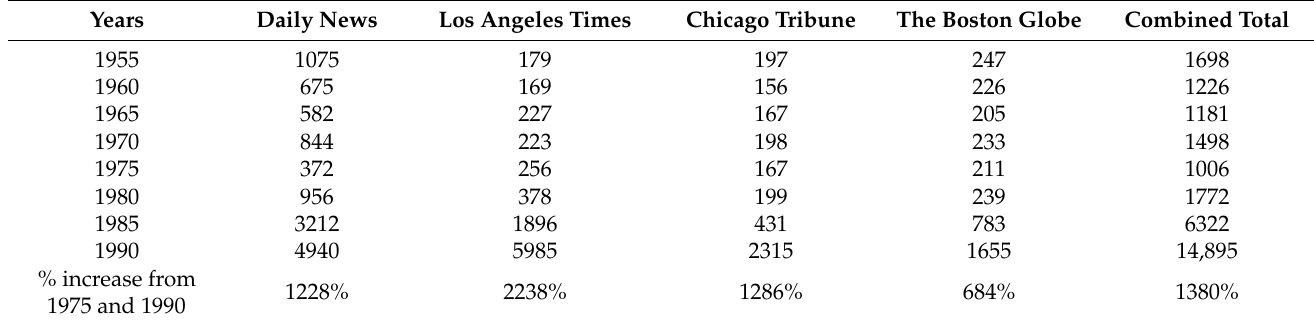
Table 1. The frequency of the word “homeless” in major newspapers between 1955–1995. Data were collected from an online digital archive of newspapers, Newspaper.com on 16 July 2021 using the search term